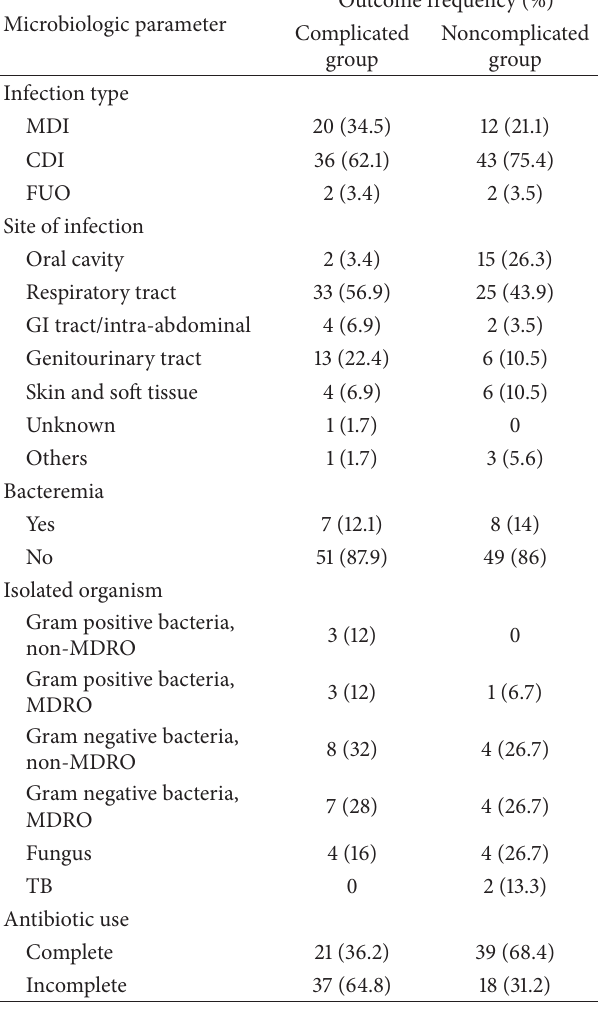
Table 3: Microbiologic profiles of febrile neutropenia cases. Table 4: Prognostic factors related to severe outcomes based on univariate